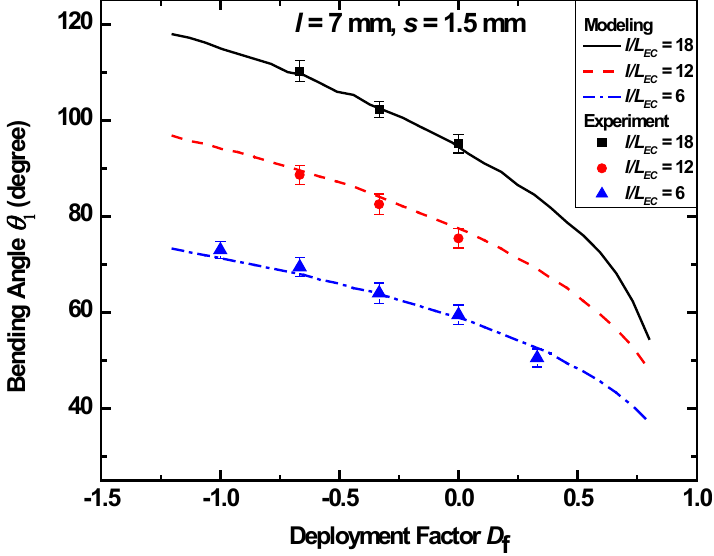
Figure 8. Modeling and experimental results of the bending angle as a function of the deployment